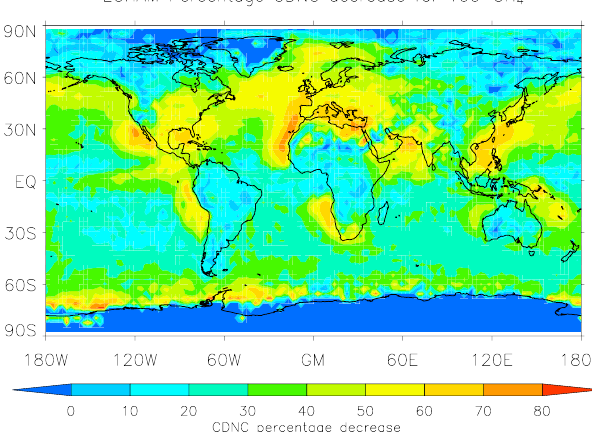
Fig. 2. Predicted total aerosol radiative forcing (in Wm − 2 ) (eval- uated as a difference in cloud radiative forcing) associated with a CH 4 concentration increased by a factor of 100, using ECHAM5- HAM.